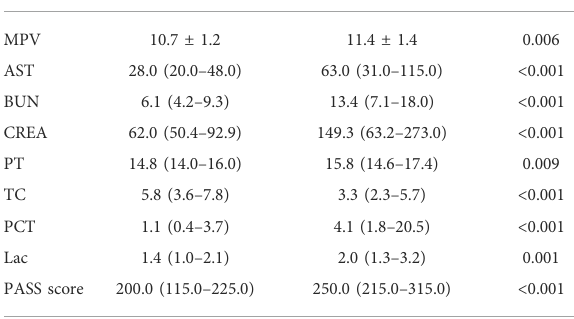
TABLE 3 Univariate analysis of recovery group and non-recovery group.